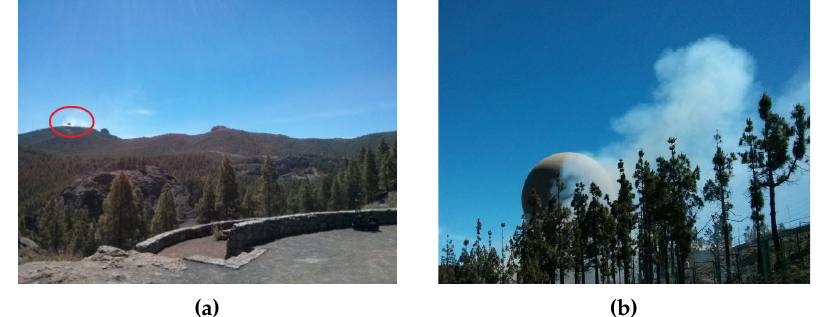
Figure 10. Controlled burn carried out by professional firefighters. ( a ) General view. ( b ) Close-up view.